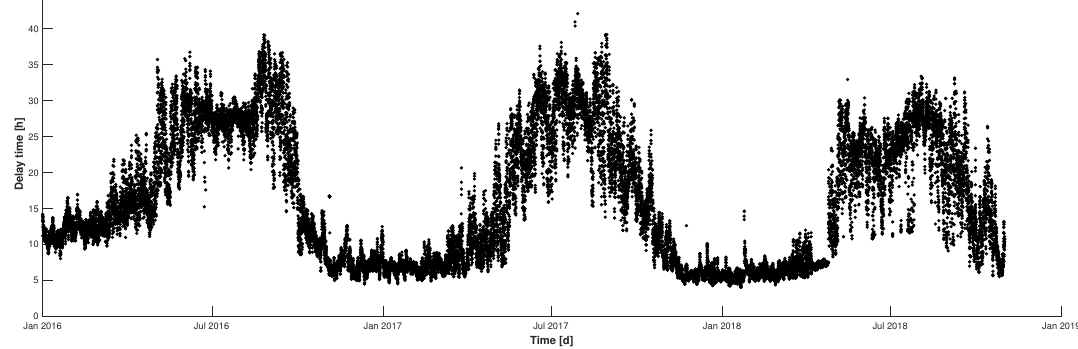
Figure 1. Seasonal variation in delay time for heat being supplied to